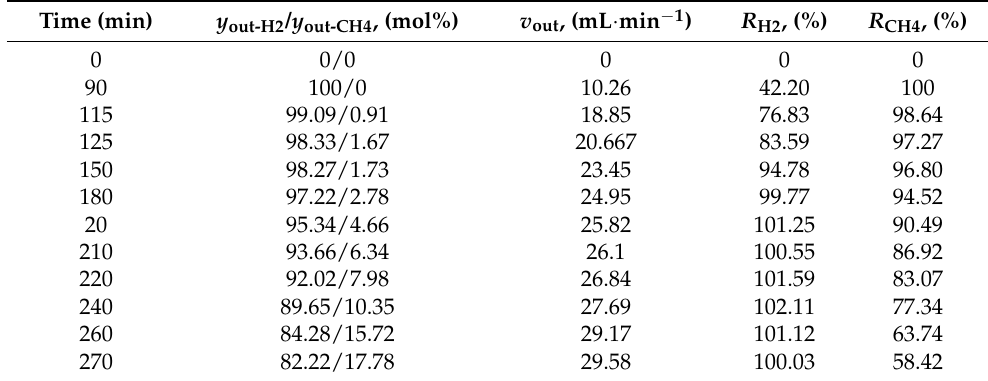
Table 4. The results of the breakthrough experiment for the CH 4 /H 2 (34.22/65.78 mol%) mixture separation in a slurry of ZIF-8 30 wt% + ethylene glycol 14 wt% + water 56 wt% at 273.15 K, 2.0 MPa, with an inlet flow rate of 36.96 mL/min.